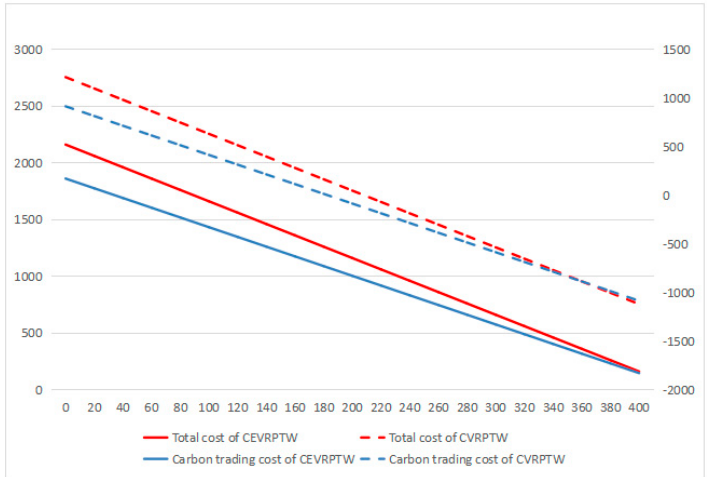
Figure 9. The change of carbon trading cost, total cost under different carbon quota when carbon price is 1.25.